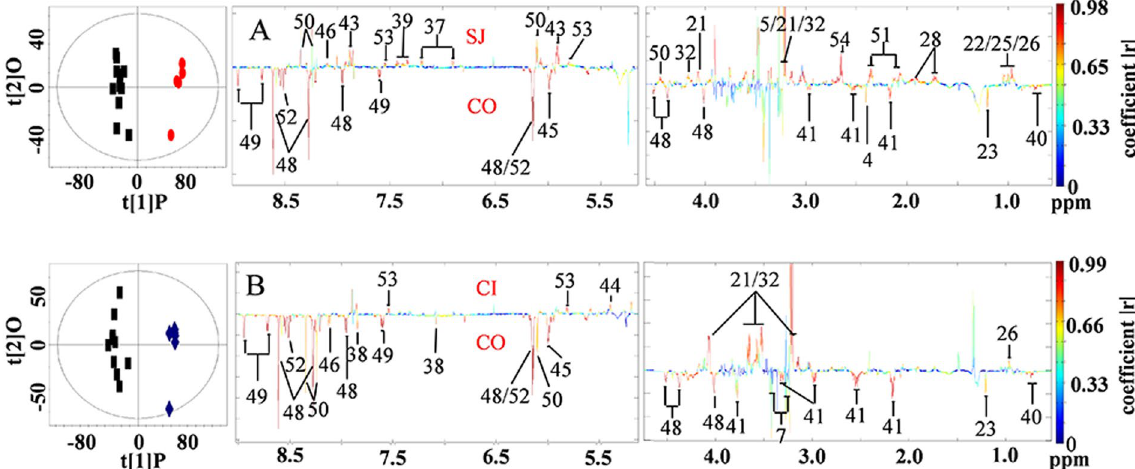
Figure 4. Scores plots and corresponding color-coded coefficient plots. These plots derived from O-PLS-DA of 1 H NMR spectra of liver extracts obtained from uninfected control mice (CO), S. japonicum infected mice (SJ), S. japonicum and S. typhimurium ATCC14028coinfected mice (CI). Signals upwards denote increases in the level compared to the control; signals downwards indicate decrease in the levels compared to the control. Keys: 4, succinate; 5, trimethylamine- N -oxide (TMAO); 7, taurine; 21, choline; 22, valine; 23, 3-hydroxybutyrate (3- HB); 25, isoleucine; 26, leucine; 28, lysine; 32, phosphocholine; 37, tyrosine; 38, histidine; 39, phenylalanine; 40, bile acid; 41, oxidized glutathione (GSSG); 43, uridine; 44, glycogen; 45, adenosine; 46, adenine; 48, adenosine triphosphate (AMP); 49, niacinamide; 50, inosine; 51, glutamate; 52, ATP; 53, uracil; 54, methionine.